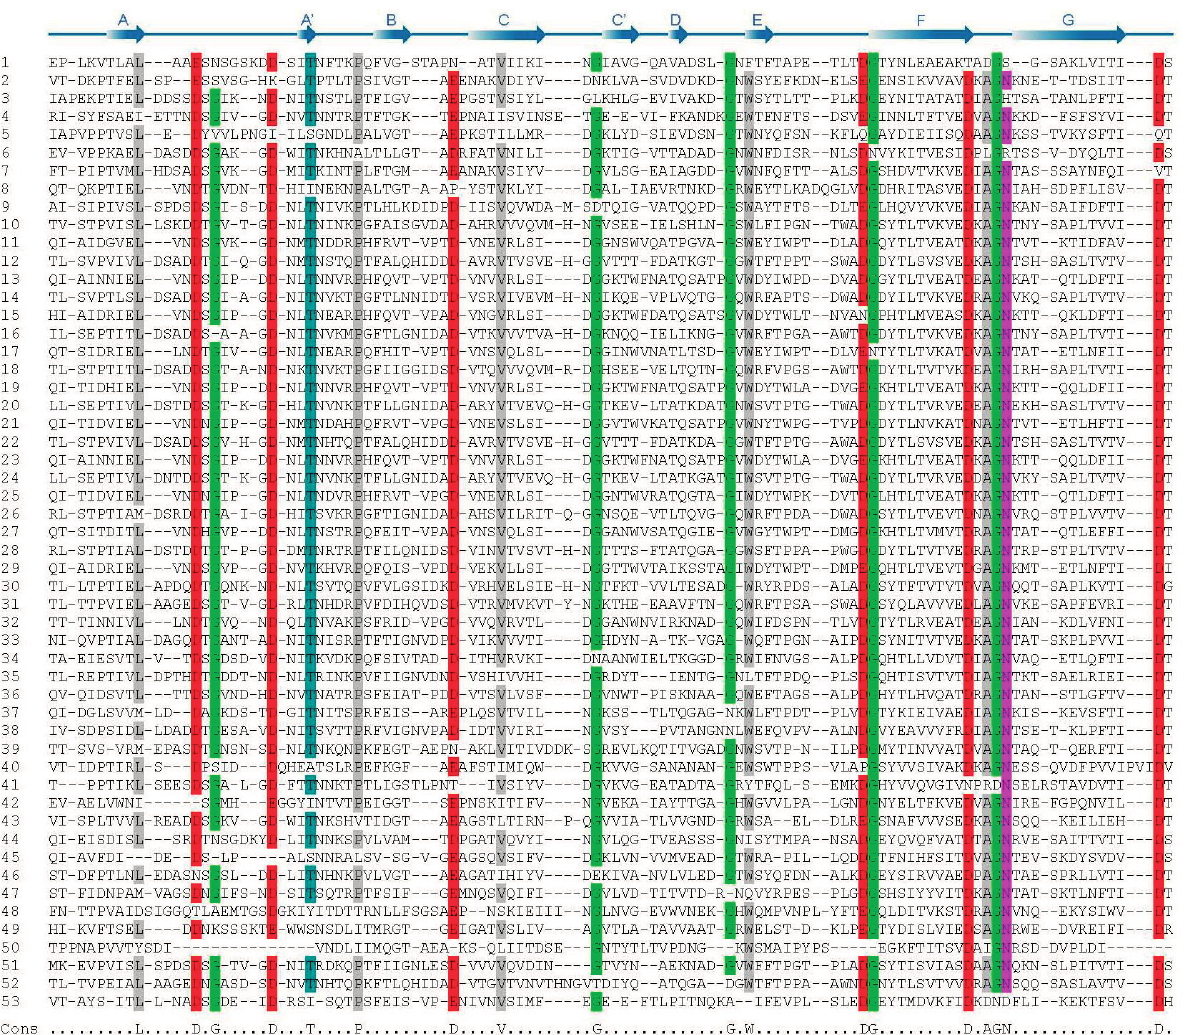
Figure 3. Primary sequence of BIg domains in the giant adhesin SiiE. Multiple sequence alignment of the 53 SiiE BIg domains (UniProtKB accession number Q8ZKG6). Highlighted are conserved amino acids (>80% presence in BIg domains) in red (D or E), light green (G), dark green (T), magenta (N), and gray (A, L, P, V, W). The consensus sequence is shown below the alignment. The scheme above the alignment indicates the β -strand assignment of domain 51 by arrows. Reproduced, with permission, from Ref.